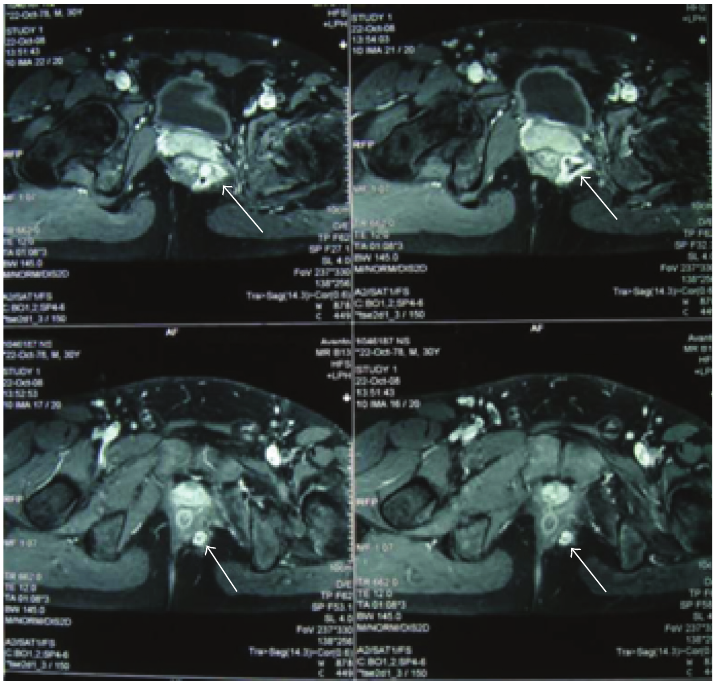
Figure 1: The pelvic MRI of the patient demonstrating the suprasphincteric fistula in ano with abscess formation (arrows).